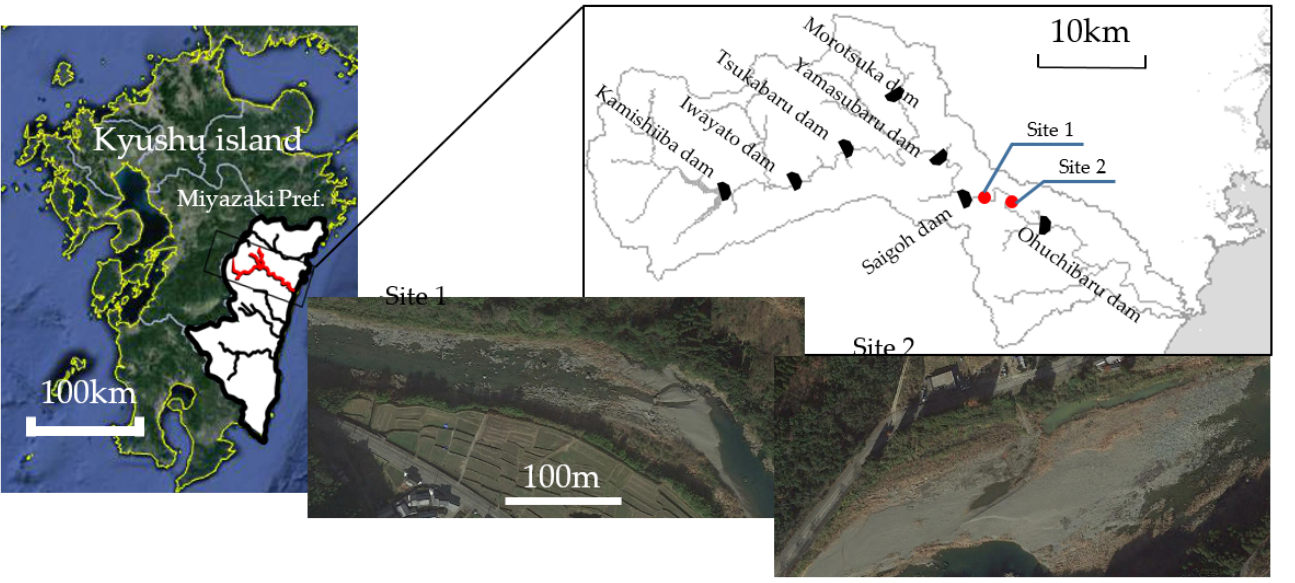
Figure 1. Location of the study site on the Mimikawa River in Miyazaki,